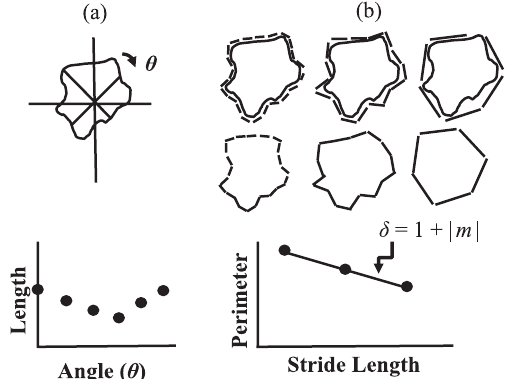
Fig. 4 Depiction of (a) Polar co-ordinate image and the data derived for analysis that would be fit to a Fourier series to obtain coefficients and (b) The use of different scales, top, to measure the surface by connecting chords around the periphery, middle, to allow estimates of the perimeter length to be plotted against the stride length on a log-log scale, bottom, from which the Frac- tal Dimension, δ , is